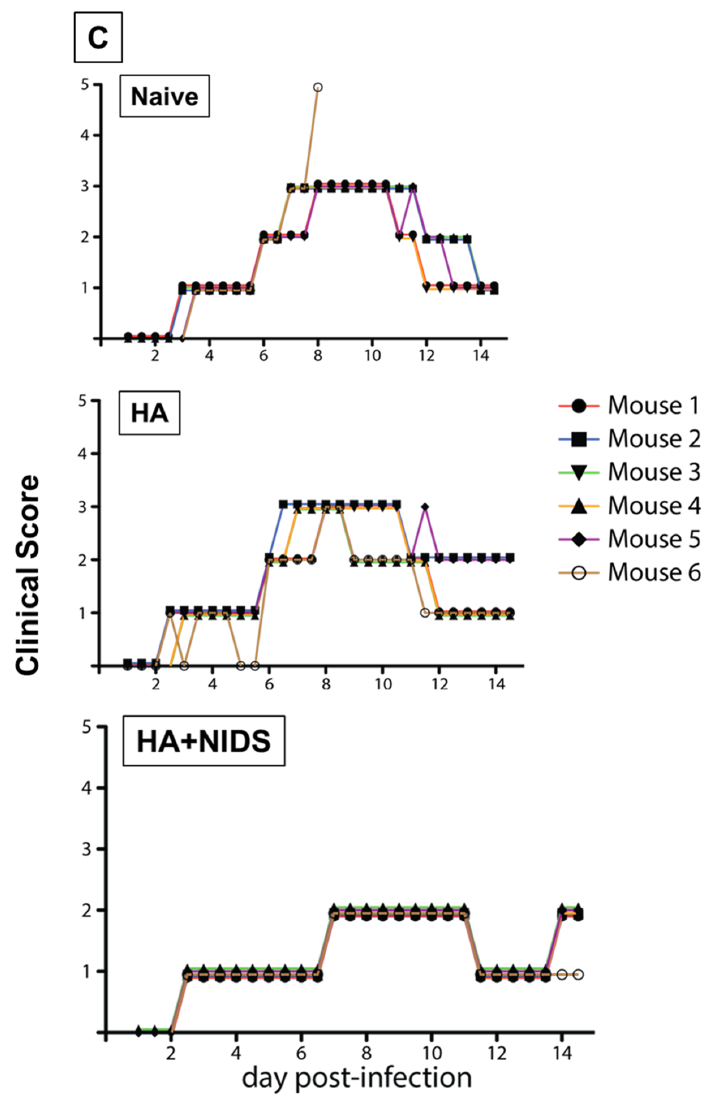
Figure 4. Protective efficacy of NIDS. Mice were vaccinated three weeks apart, twice intramuscularly (IM). Groups of six mice per group were vaccinated with HA alone, HA mixed with NIDS, or HA mixed with Sq. oil. Mice were also similarly vaccinated twice IM with inactivated virus alone, or with inactivated virus mixed with NIDS. ( A ) Hemagglutination inhibition titers were measured in sera collected 2 weeks post 2nd vaccination; ( B ) Mice were challenged 3 weeks post 2nd vaccination intra ‐ nasally with live influenza and Lung pfu titers were measured; ( C ) Clinical scores of mice following vaccinations and intranasal challenge with live influenza virus. The data in ( A , B ) are presented as mean values from six mice per group ± SEM (error bars). Each dot or line represents an individual mouse within a specific vaccination group. Differences with statistical significance between groups are denoted with lines with one or more asterisk, represented as * p ≤ 0.05, ** p < 0.01 and *** p < 0.001.